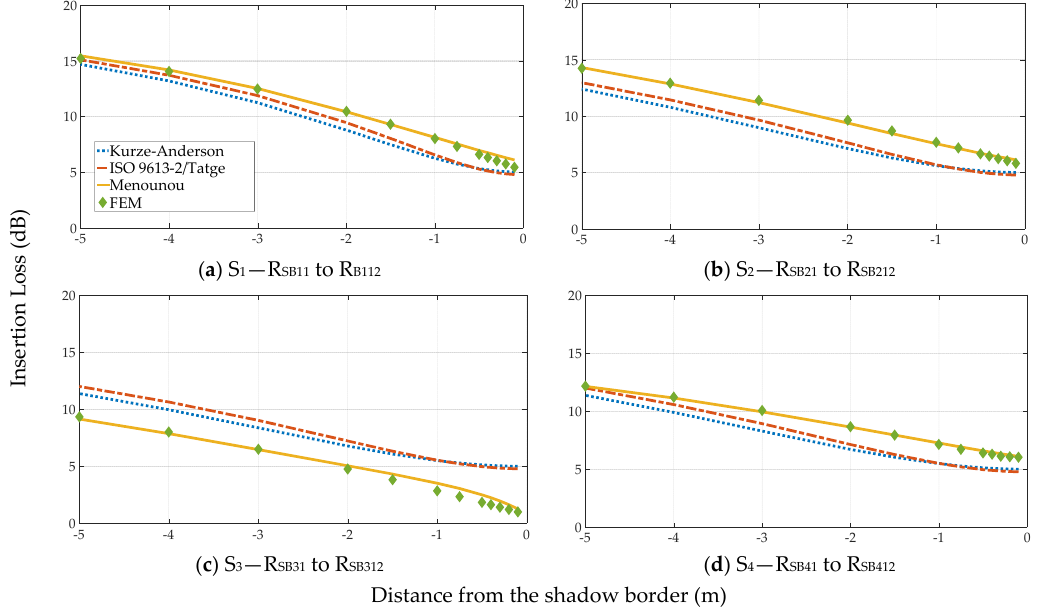
Figure 10. Comparison of calculation of insertion loss between FEM and various formulae for various source and receiver positions near the barrier inside the shadow zone (300 Hz).